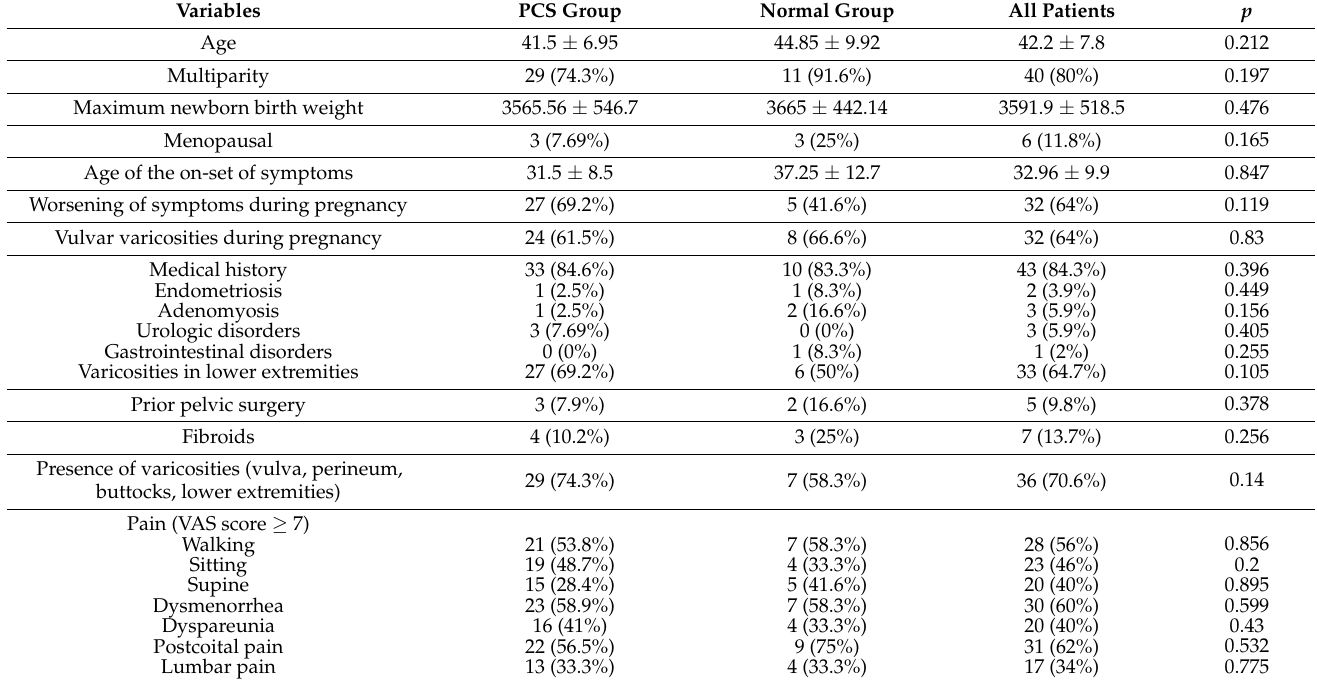
Table 1. Epidemiological